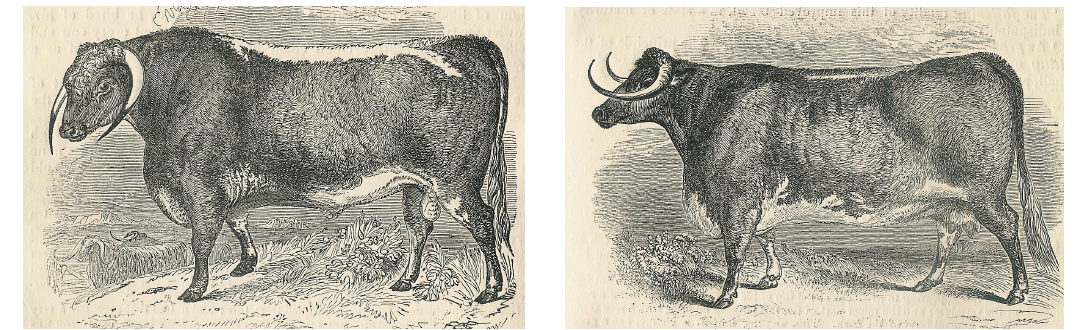
Figure 12. New Leicester bull and cow